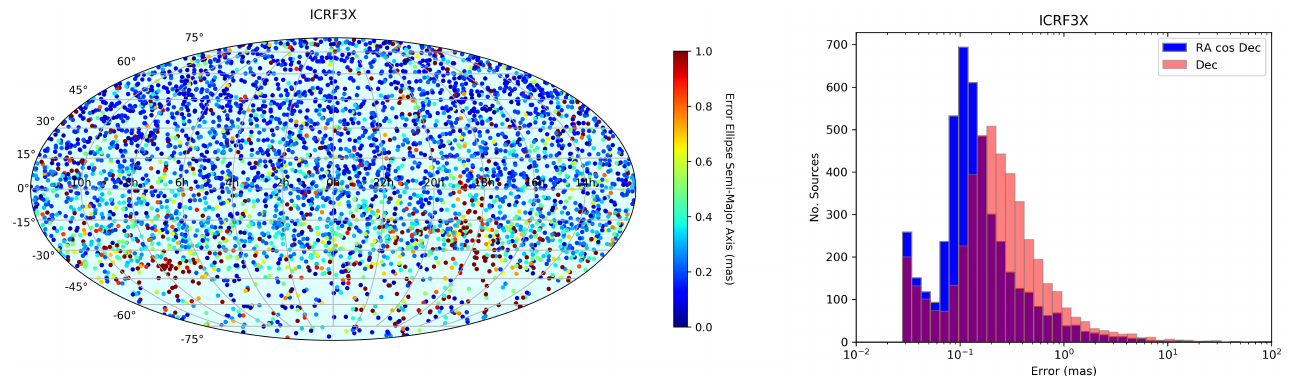
Figure 2. Left: Sky distribution of the 4536 sources in the ICRF-3 S/X frame. Each source is plotted as a dot color-coded according to its position uncertainty (defined as the semi-major axis of the error ellipse derived from the right ascension and declination uncertainties and correlation coefficients between the coordinates). The color scale ranges from 0 to 1 mas. Right: Distribution of coordinate uncertainties for the same 4536 sources. Right ascension is shown in blue, declination in salmon, and the superimposed portion in purple. Reproduced from [4].